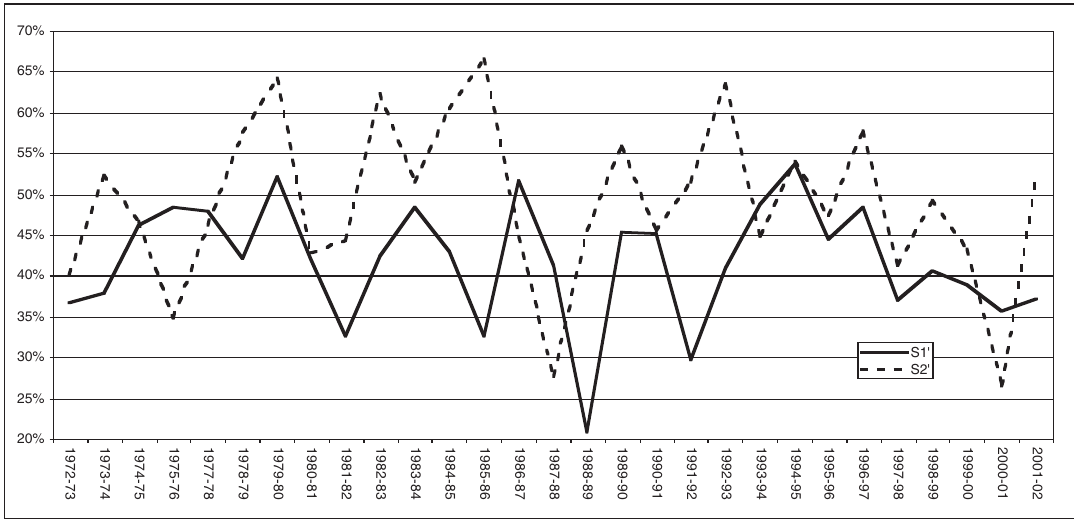
Figura 4 – L’indice S’ per le squadre di